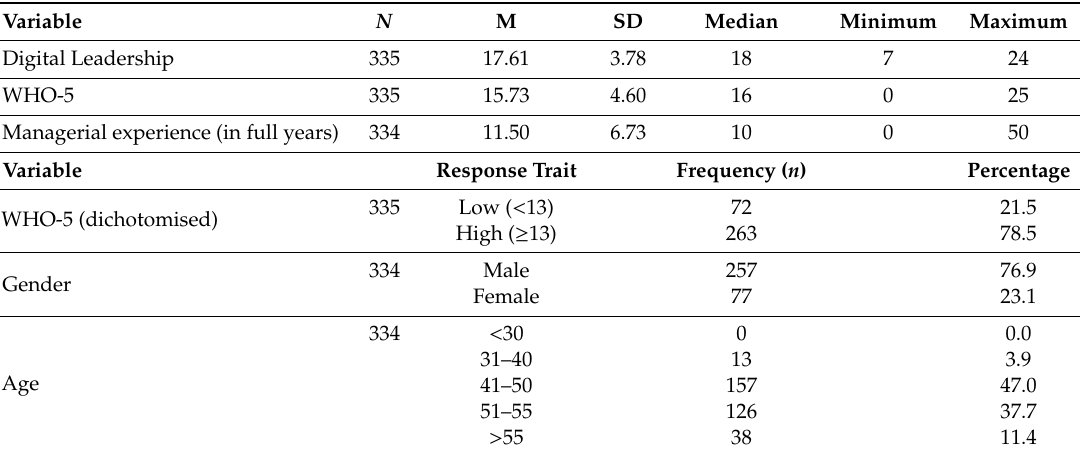
Figure 1. Flowchart of the selection of the managers’ sample. Table 1. Descriptive characteristics for all model variables.